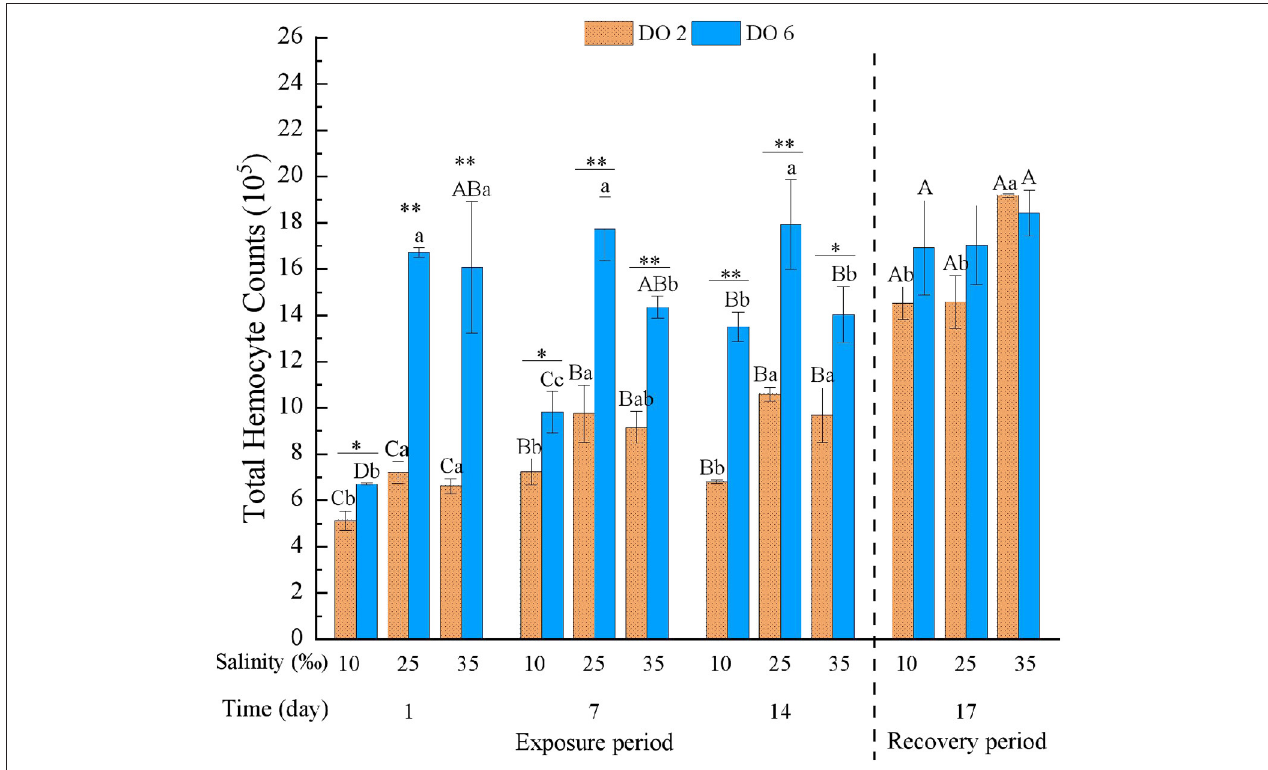
FIGURE 3 | Total hemocyte count (THC) of C. hongkongensis exposed to six combinations of salinity (10, 25, and 35 ‰ ) and DO (2 and 6 mg/L) at 1, 7, and 14 days during the exposure period and 3 days for the recovery period. Different capital letters indicate significant differences among time points within each salinity level in hypoxia level (2 mg/L) or control group (6 mg/L) ( p < 0.05). Different small letters indicate significant differences between salinity within each time point in salinity level in hypoxia level (2 mg/L) or control group (6 mg/L) ( p < 0.05). Asterisk indicates significant differences between DO within each time point and fixed salinity treatment, in which * represents significant difference ( p < 0.05) and ** represents highly significant difference ( p <